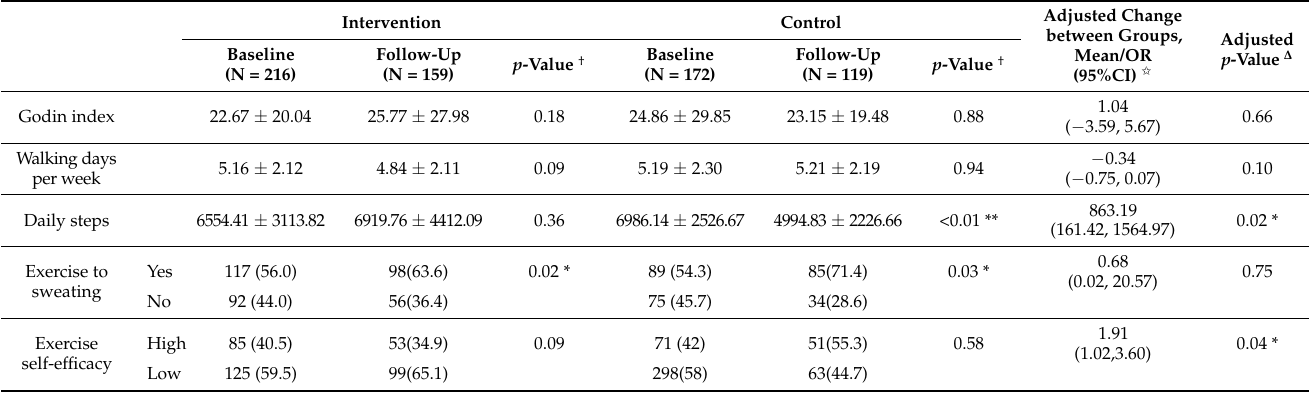
Table 4. Comparison of physical-activity changes between the intervention and control worksites from baseline to